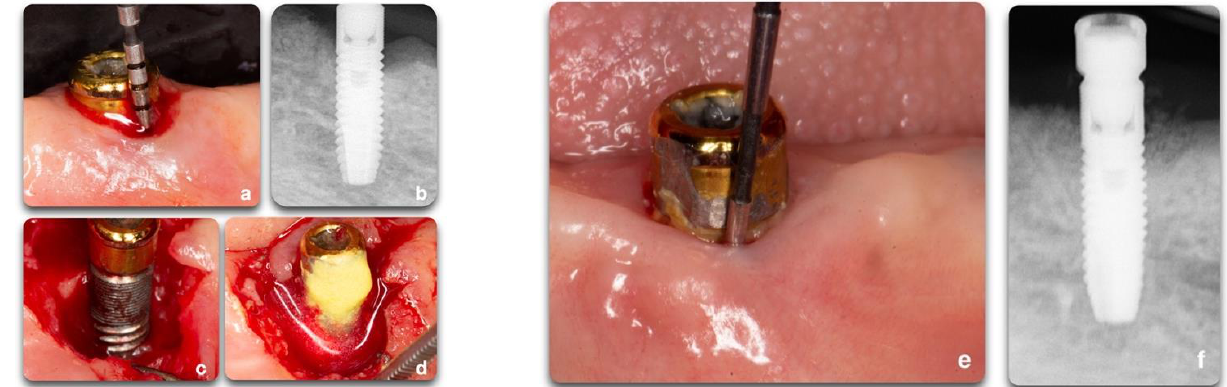
Figure 10. Regenerative peri-implant therapy for implant area #22. ( a , b ) Pre-operative clinical and radiographic presentation. BoP, SUP, PD > 5mm. ( c ) Defect configuration after the elevation of the full-thickness flap. ( d ) Decontamination with rotating titanium brushes, saline, and chlorhexidine rinse, and 2 min of tetracycline hydrochloride soluble powder applied to the implant surface. Bone grafting application and flap closure around existing locator abutment (LOCATOR Astra Tech EV Overdenture Abutment © Dentsply Sirona); ( e , f ) 12 months post-operative clinical and radiographic outcomes. To be noted is the partial fill of the intra-bony defect with a residual supra-crestal fixture.